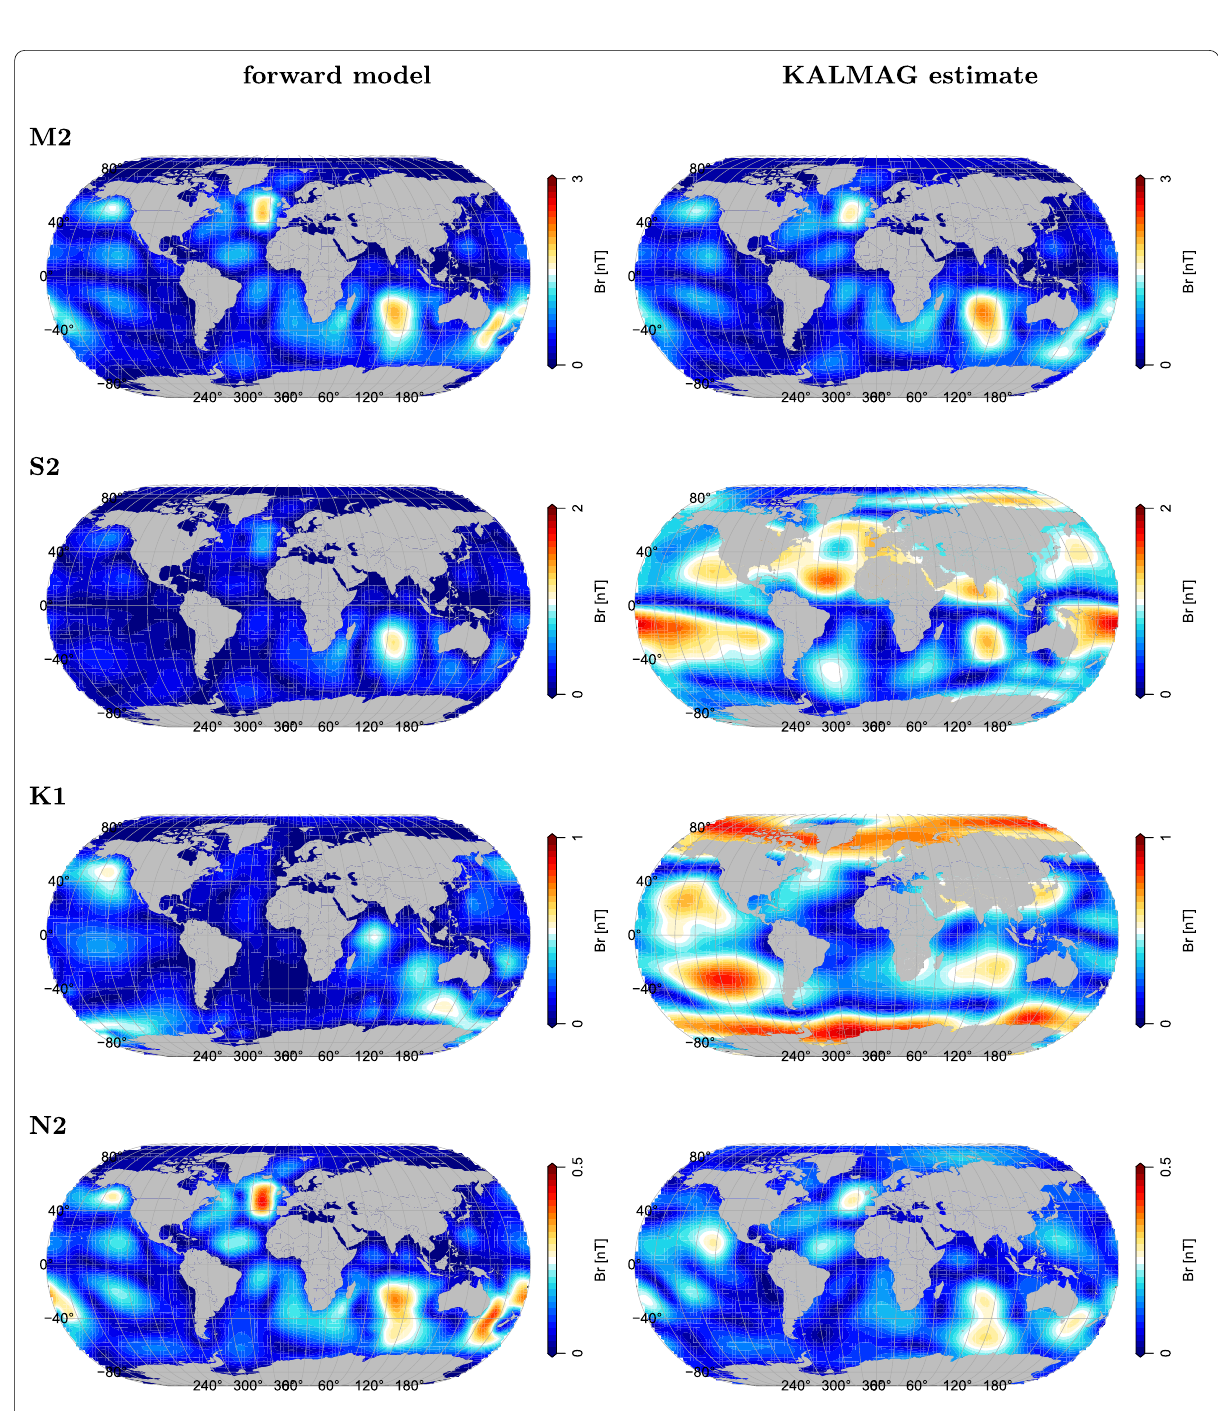
Fig. 1 Tidal radial magnetic fields (M2, S2, K1, N2). Left column: results from forward modeling of ocean tides. Right column: results from KALMAG inversion of Swarm and CHAMP observations. All fields are represented at the satellite height of 430 km above sea level. Please note the different color bar